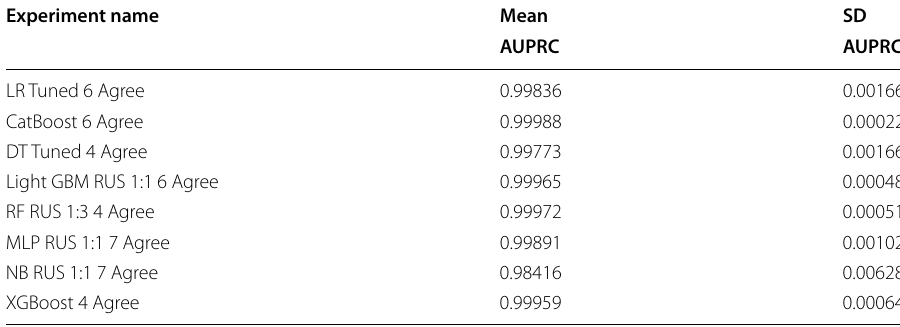
Table 36 Maximum AUPRC by classifier for the keylogging attack type; mean and standard deviations of AUPRC, (10 iterations of 5-fold